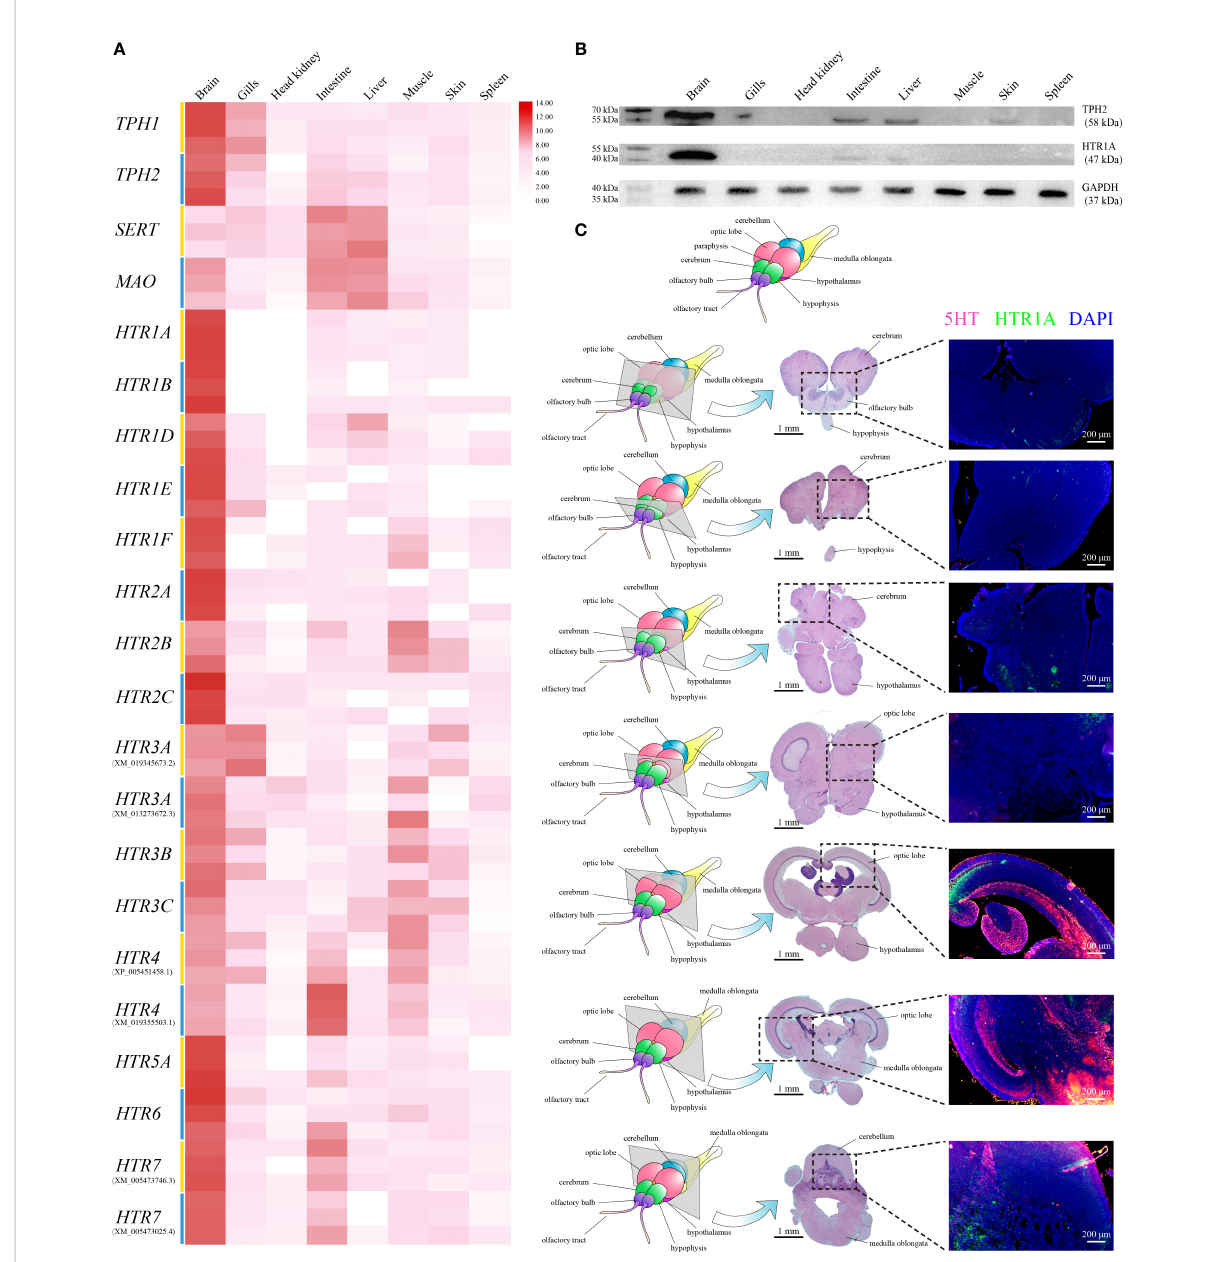
FIGURE 2 (A) Relative expression levels of On-TPH1 , On-TPH2 , On-SERT , On-MAO , and On-HTRs mRNA among different tissues in healthy Nile tilapia, assessed via qRT-PCR. n = 3. Expression level of each gene in the brain was set as 1000. (B) Western blot analysis of On-HTR1A and On-TPH2 in different tissues of healthy Nile tilapia. GAPDH was applied as a reference protein. See Figure S2 for the complete fi gures. (C) Location of 5- HT and On-HTR1A in the Nile tilapia brain. Top, diagram of Nile tilapia brain morphology. Left column, diagram of sections with typical brain structures in healthy Nile tilapia. Midcolumn, H&E of each selected section. Right column, On-HTR1A (green), 5-HT (red), and nucleus (blue) of each section determined via immuno fl uorescence